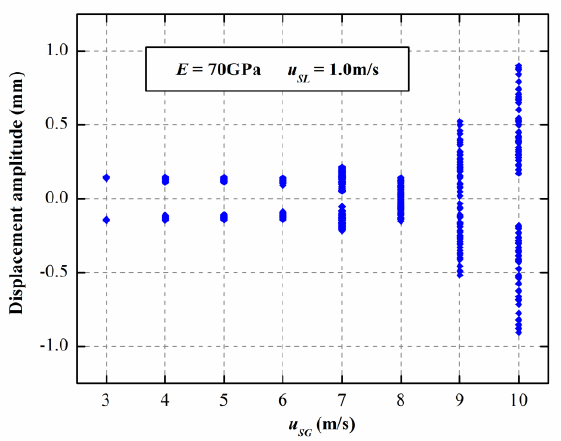
Figure 5. Bifurcation diagram for the midpoint of the piping system for E = 70